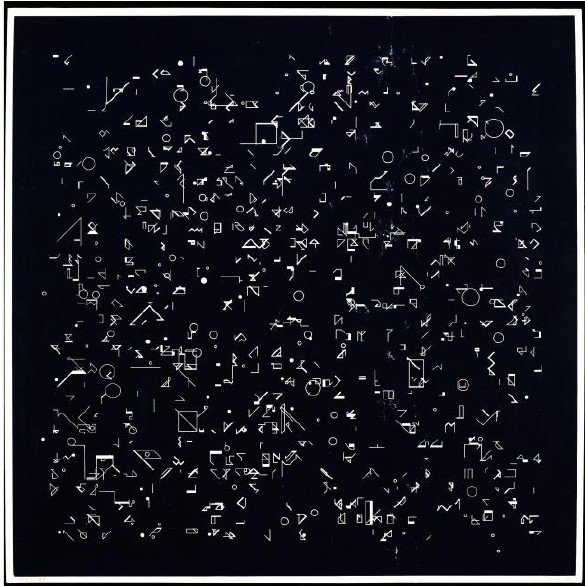
Figure 5. Manfred Mohr: A formal language (P-49), 1970. Credit: V&A Museum London.